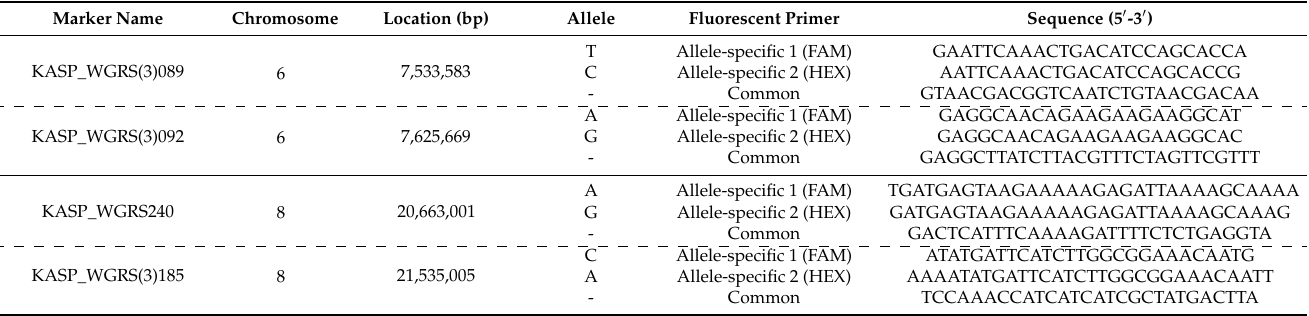
Table 3. Primer sequence details of (KASP™) markers associated to GSB resistance.